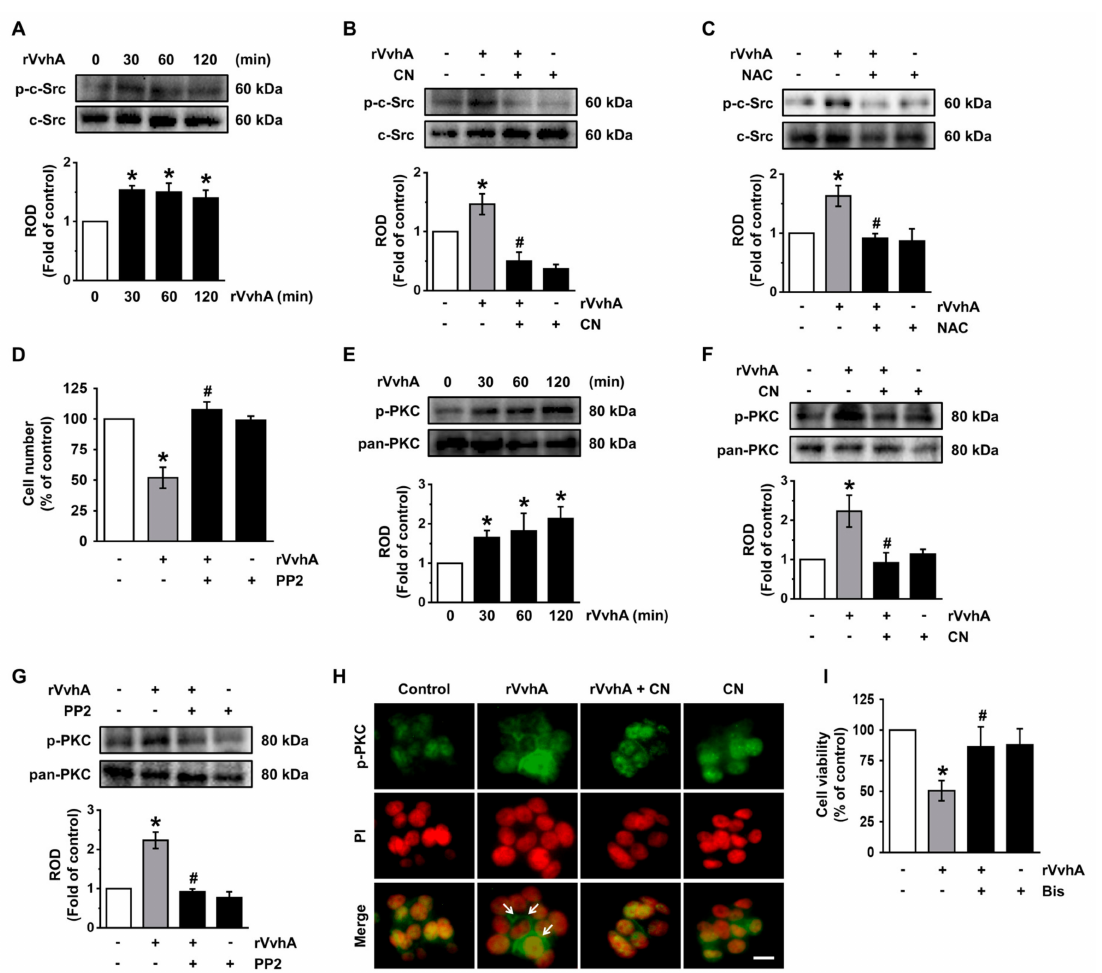
Figure 3. CN regulates the activation of c-Src and PKC induced by rVvhA. ( A ) Time responses of phosphorylation of c-Src in cells exposed to rVvhA is shown. n = 3. * p ≤ 0.05 vs. control. ( B ) The inhibitory e ff ect of CN on phosphorylation of c-Src in rVvhA-treated cells is shown. n = 3. * p ≤ 0.05 vs. control. # p ≤ 0.01 vs. rVvhA alone. ( C ) Cells were pretreated with NAC prior exposure to rVvhA for 30 min. n = 3. * p ≤ 0.05 vs. control. # p ≤ 0.01 vs. rVvhA alone. ( D ) Cells were pretreated with PP2 (10 µ M) for 30 min prior exposure to rVvhA for 24 h. Cell viability was determined by cell counting assay. n = 4. * p ≤ 0.01 vs. control. # p ≤ 0.001 vs. rVvhA alone. ( E ) Phosphorylation of PKC in cells exposed to rVvhA is confirmed by western blot. n = 3. * p ≤ 0.05 vs. control. ( F ) The inhibitory e ff ect of CN on phosphorylation of PKC in rVvhA-treated cells is shown. n = 3. * p ≤ 0.05 vs. control. # p ≤ 0.01 vs. rVvhA alone. ( G ) Cells were pretreated with PP2 prior exposure to rVvhA for 30 min. n = 3. * p ≤ 0.01 vs. control. # p ≤ 0.001 vs. rVvhA alone. ( H ) Cells were treated with CN and rVvhA to confirm the membrane translocation of PKC. Scale bars, 100 µ m (Original magnification × 400). n =